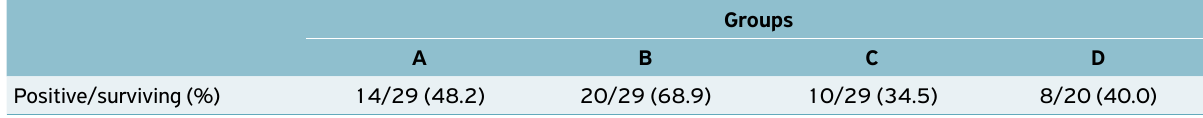
Table 2. Isolation of wild SG 287/91 at 28 dpi in liver and spleen samples of surviving chickens from groups A, B and C (vaccinated) and group D (unvaccinated).